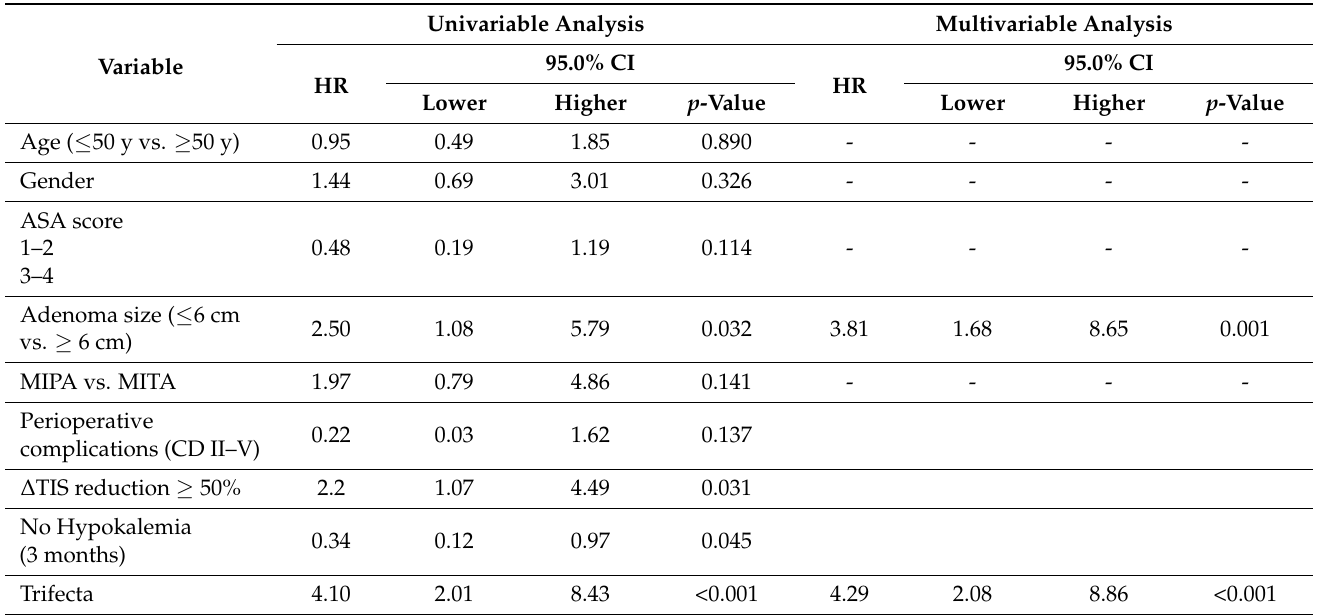
Table 9. Univariable and multivariable logistic regression analysis to identify predictors of simultane- ous complete clinical and biochemical success according to PASO